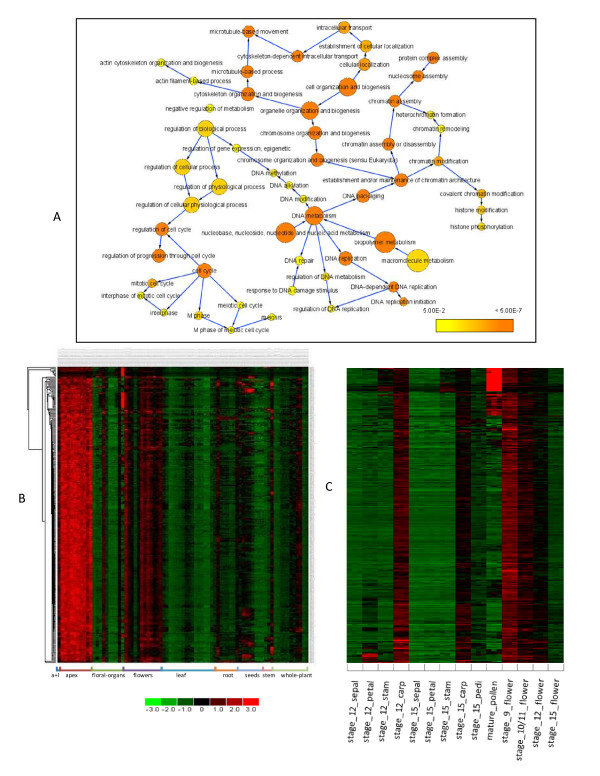
Functional analysis of module 4. (A) Significantly over-represented GO terms detected in module 4. (B) Co-expression patterns of 280 module genes over the 237 arrays which made up a gene expression map of Arabidopsis development [19]. In the heat map, each row represents a gene, and each column represents an array. Prior to hierarchical clustering, a gene's expression values over the 237 arrays were processed so that they had a zero mean and unit standard deviation. Arrays sampled from the same tissue were grouped together. 'a+l' represents the tissue that includes both shoot apex (vegetative) and young leaves. The heat map was generated using dChip software [68]. (C) A closer examination of the expression pattern of 280 module genes in different floral organs and whole flower tissues at different development stages. To generate the heat map, genes' expression values were extracted from the 280 × 237 data matrix, which were used to produce the heat map depicted in (B). Stage_XX represents a flower development stage, 'stam' represents stamen, 'carp' represents carpel, 'pedi' represents pedicel. For each experimental condition (e.g. stage_12_sepal), three replicates were measured.